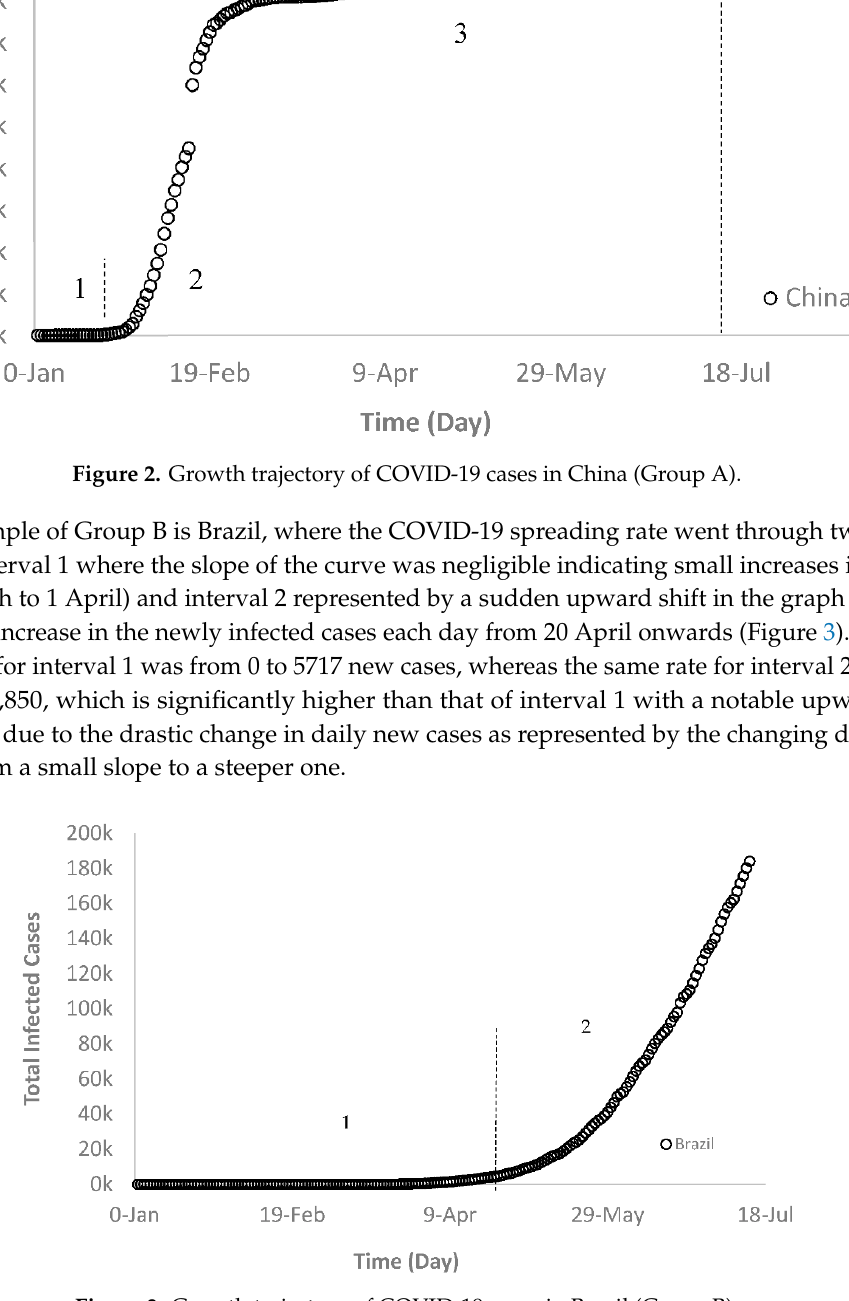
Figure 3. Growth trajectory of COVID-19 cases in Brazil (Group B).